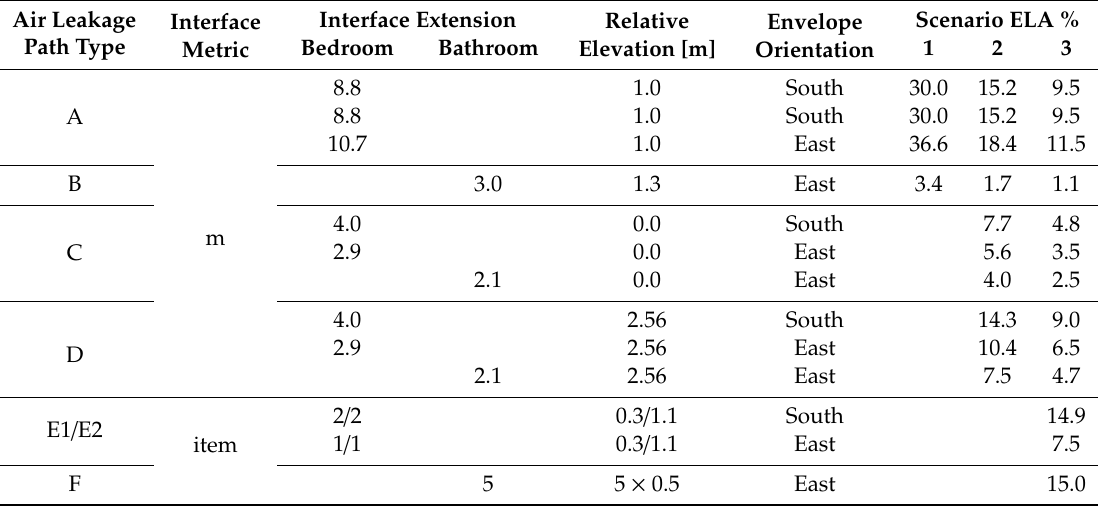
Table 6. Air leakage type, metric, extension, envelope orientation, and relative importance in ELA percentage of the modeled scenarios. Relative elevation refers to mid-height of the air leakage path to floor